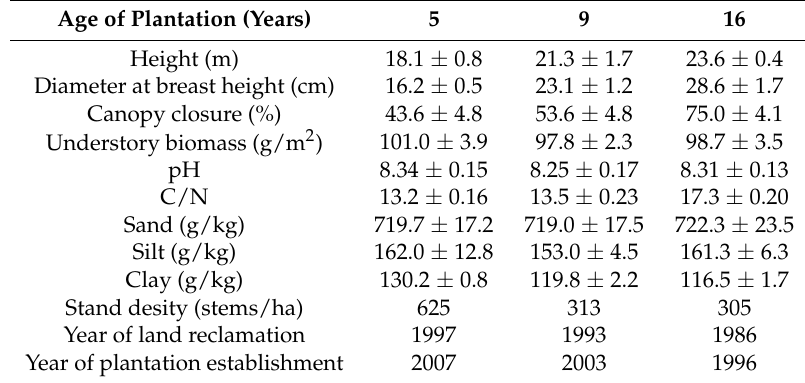
Table 1. Soil properties and stand characteristics in poplar plantations at different ages (mean ± s.e.m., n =